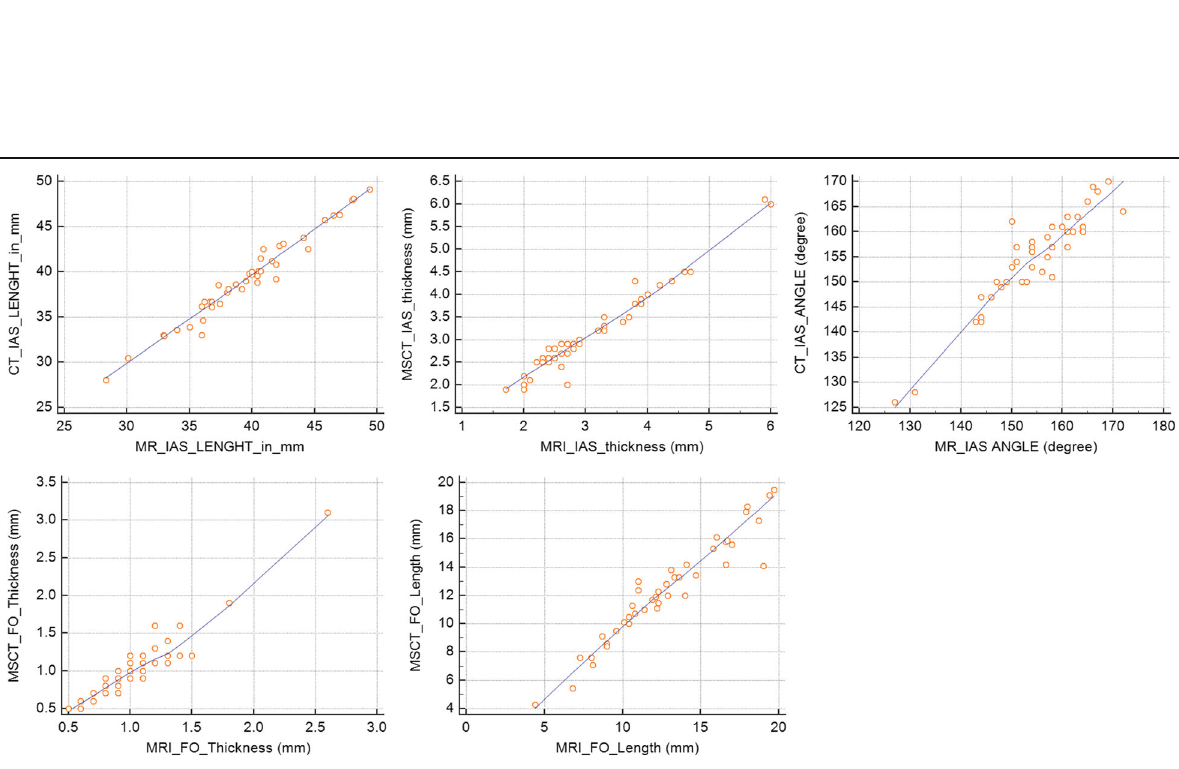
Fig. 3 Correlation scatter graphs of both techniques. It demonstrates the close relationship between various measurements of the interatrial septum (IAS) obtained using CMR and IAS length, maximal IAS thickness, fossa ovalis thickness, fossa ovalis length, and IAS angle. FO, fossa ovalis; IAS, interatrial septum; NS, not